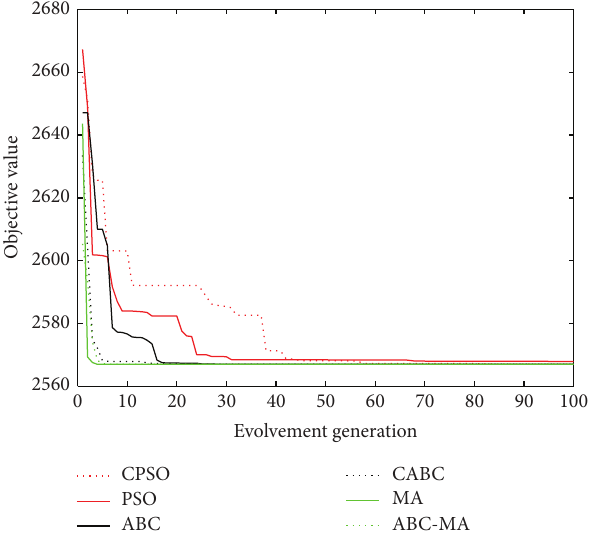
Figure 16: The convergence curve of the scale data.